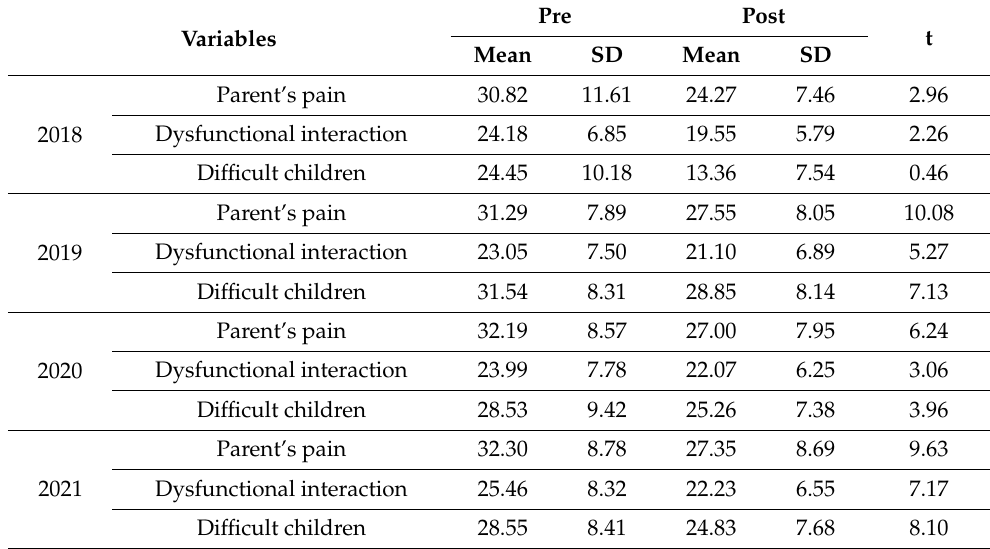
Table 6. Results of K-PSI-SF subdomains for each year 2018–2021.